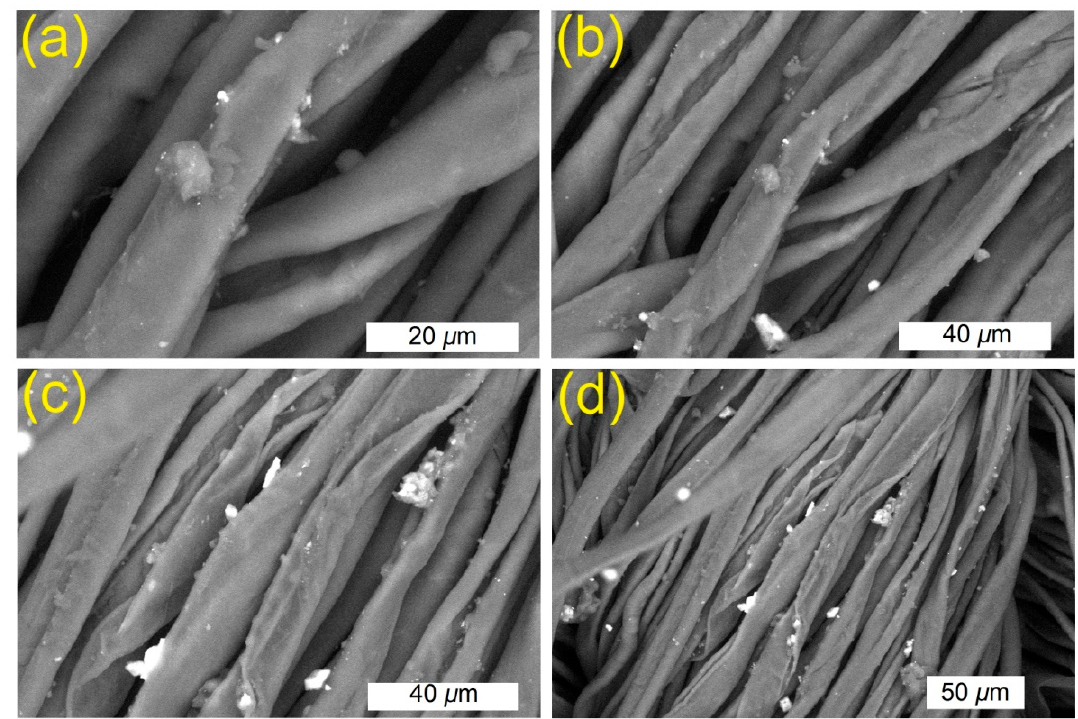
Figure 4. SEM images of TiO 2 NPs incorporated plasma-activated ( a , b ) and Ag 0 /TiO 2 incorporated plasma-activated ( c , d ) fibers. Table 1. Elemental contents of viscose fibers.